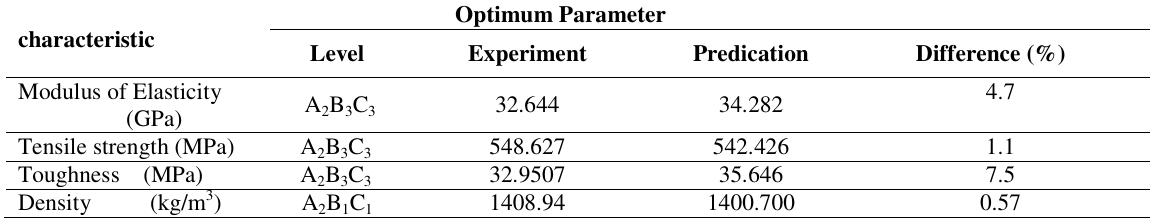
Optimum Parameter Level